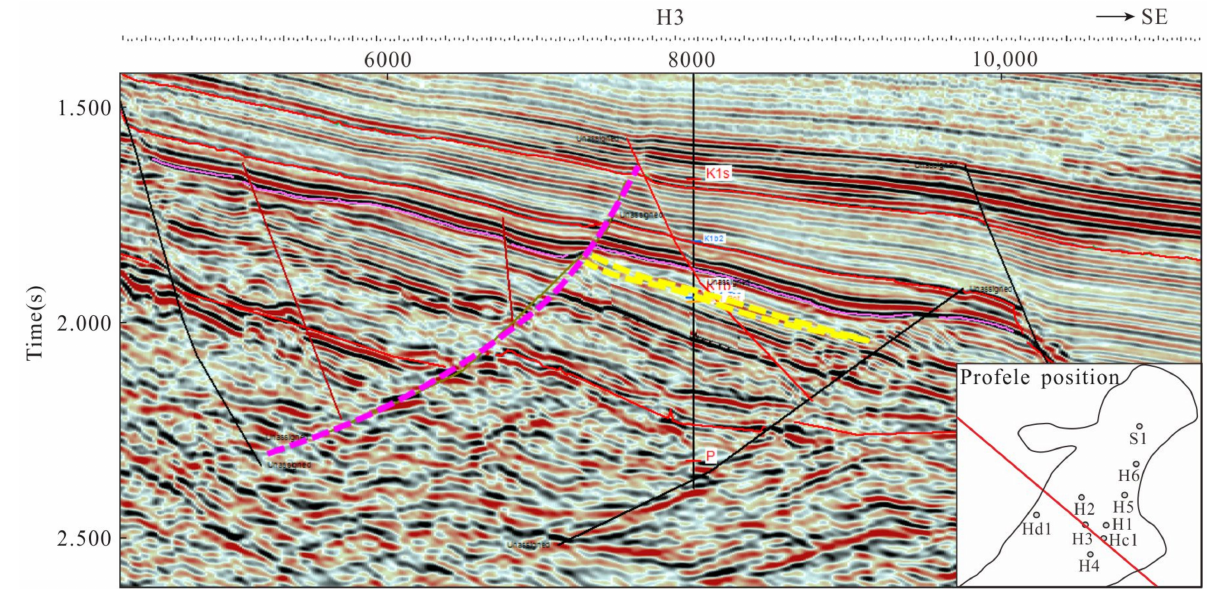
Figure 7. Profile characteristics of sandstone reservoirs in Well